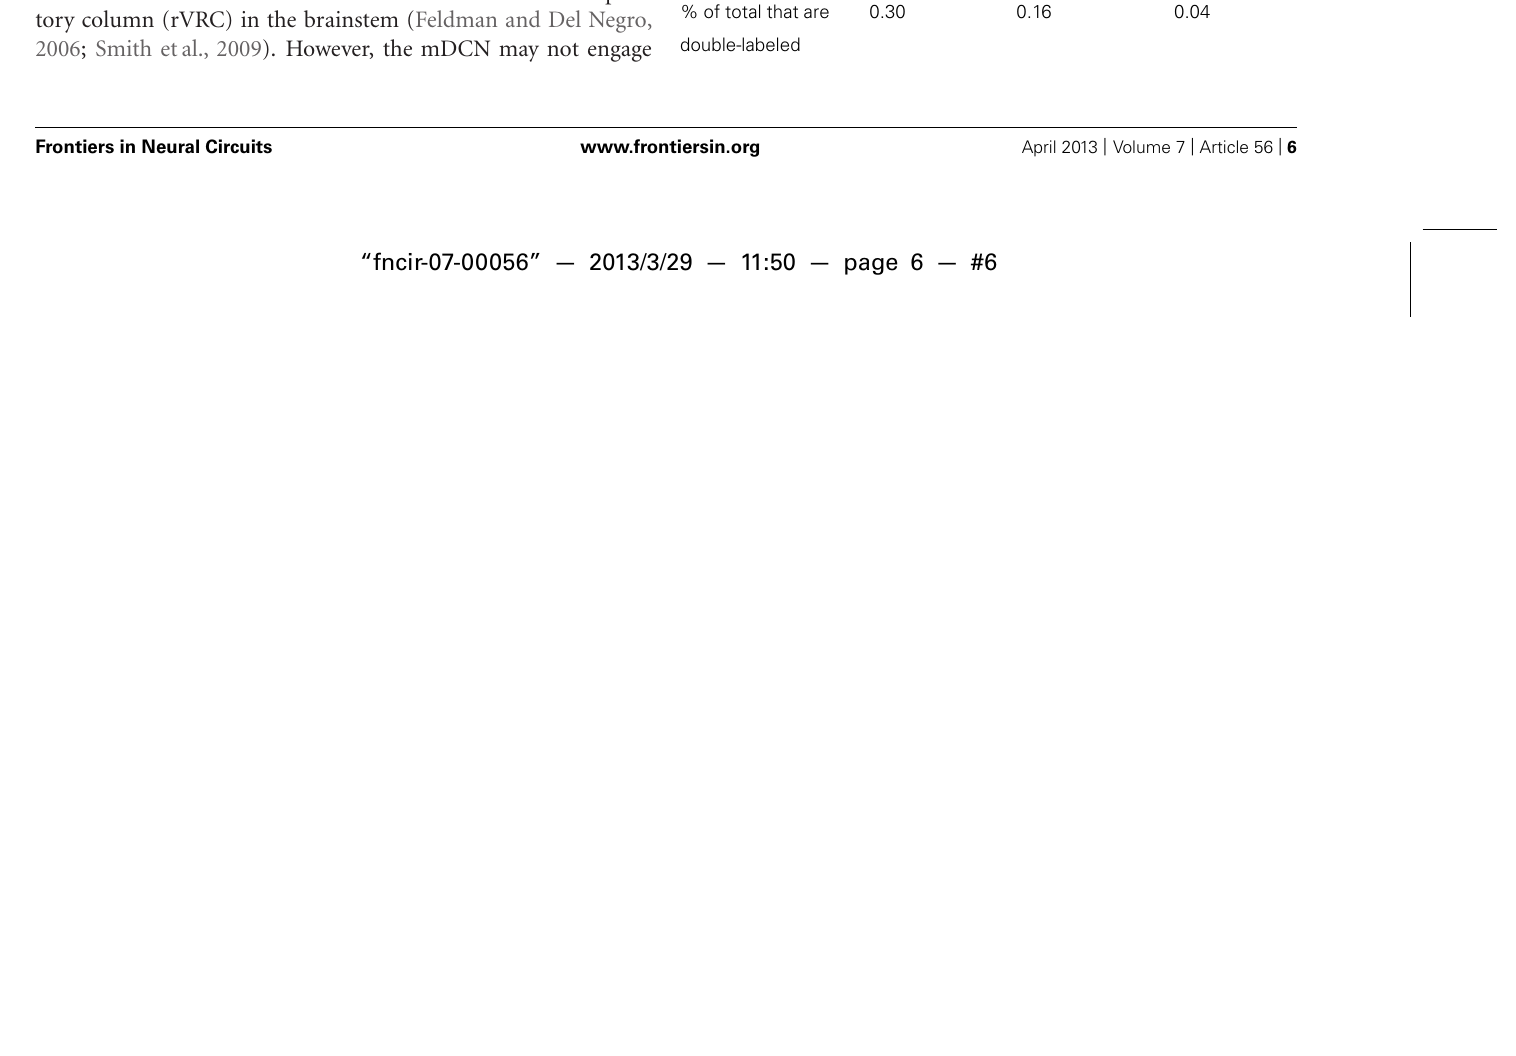
bregma. (E) Plots of cells in the mDCN at rostral to caudal levels in a single animal (left to right); a subset of cells at each level are double- labeled (blue circles). Red and green circles correspond to cells labeled by rostral and caudal injections, respectively. Approximate rostral–caudal levels are − 6.2, − 6.4, and − 6.6 mm from bregma (left to right). Scale bars: (C) = 100 mm; (D) = 50 mm. Atlas sections from Paxinos and Franklin (2001).